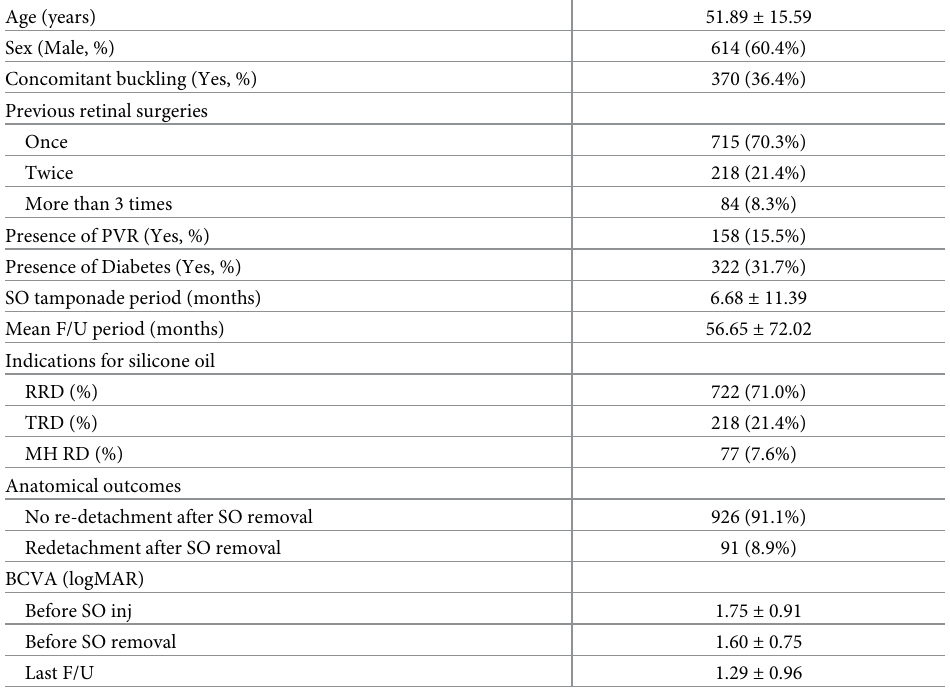
Table 1. Demographics, surgical and visual outcomes (n =